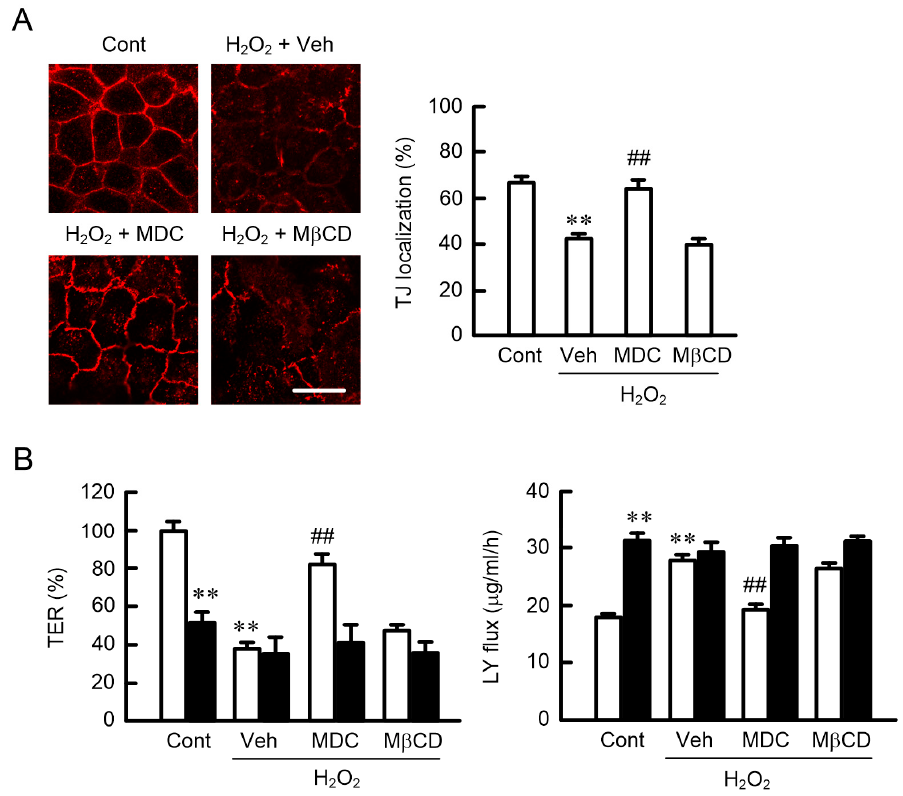
Figure 5. Rescue of the H 2 O 2 -induced mislocalization of CLDN1 by monodansylcadaverine (MDC). ( A ) Cells were pre-incubated in the absence (Veh) or presence of 5 μ M MDC and 10 μ M methyl- β - cyclodextrin (M β CD) for 30 min, followed by exposure to 200 μ M H 2 O 2 . Control cells (Cont) were not treated with H 2 O 2 and endocytosis inhibitors. The cells were immunostained with anti-CLDN1 antibodies. Scale bars indicate 10 μ m. The TJ localization of CLDN1 is represented as the percentage of the total amount. ( B ) Negative (open bars) or CLDN1 siRNA-transfected cells (closed bars) were incubated with H 2 O 2 , MDC, and M β CD. TER and paracellular LY flux were analyzed using a volt-ohmmeter and fluorescence spectrometry, respectively. n = 4–6; ** p < 0.01 significantly different from Cont or Cont of negative siRNA; ## p < 0.01 significantly different from Veh of H 2 O 2 .